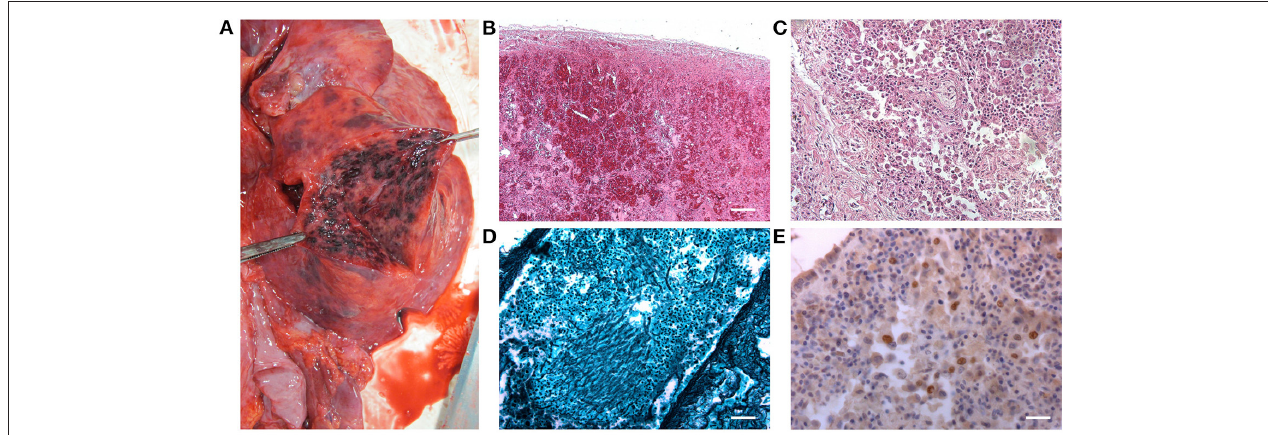
FIGURE 3 | Macroscopic appearance of the inferior lobe of the right lung after surface incision (A) . Histopathological characterization by hematoxylin and eosin stain of the right lung parenchyma: hemorrhagic invasion of the air spaces (B) and the typical appearance of the tissue in interstitial pneumonia (C) were detected [Scale bars: 200 µ m (B) ; 50 µ m (C) ]. Grocott–Gomori’s methenamine silver stain showing Aspergillus branching hyphae (black) infiltrating the lung parenchyma (D) (Scale bar: 50 µ m). Immunohistochemical staining for CMV, highlighting the presence of immunoreactive cells (E) (Scale bar: 25 µ